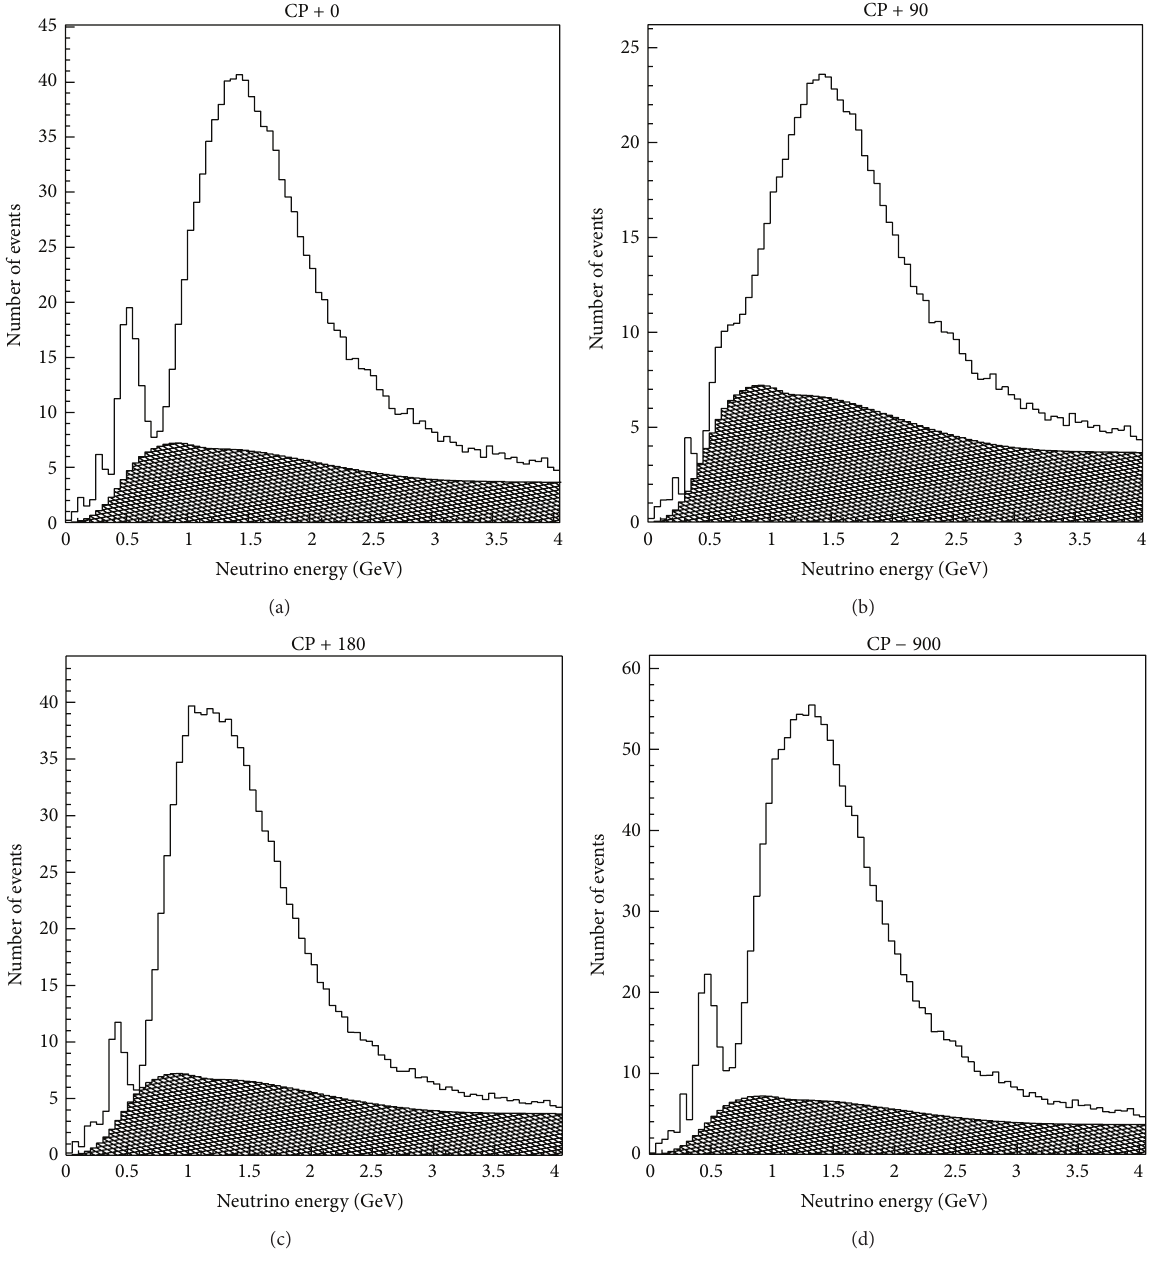
= 0 ∘ (a), 90 ∘ (b), 180 ∘ (c), and 270 ∘ (d) cases. CP